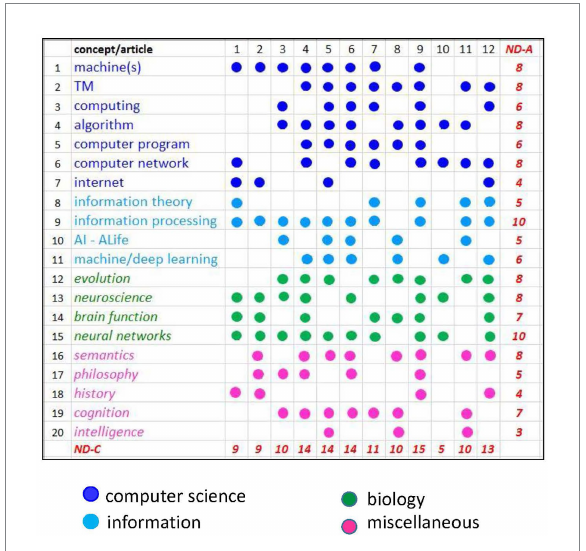
FIGURE 1 The Special Issue at a glance. The figure is a kind of [0,1] matrix that describes the 12 articles in this Special Issue by means of 20 concepts (keywords) whose presence is denoted by a dot. The external column shows the number of Articles per concept (ND- A), the external row the number of Concepts per articles [ND-C; i.e., the Node Degree (ND), the number of links per node, in the corresponding bipartite graph, not shown]. Articles are as follows: Cobb (1), Gomez-Marin (2), Chirimuuta (3), Brette (4), Bongard- Levin (5), Richards-Lillicrap (6), Fraser (7), Roli-Jaeger-Kauffman (8), Danchin-Fenton (9), Davis (10), Gershenson (11), Graham (12). Abbreviations: TM-Turing machine; AI-Artificial Intelligence; ALife-Artificial